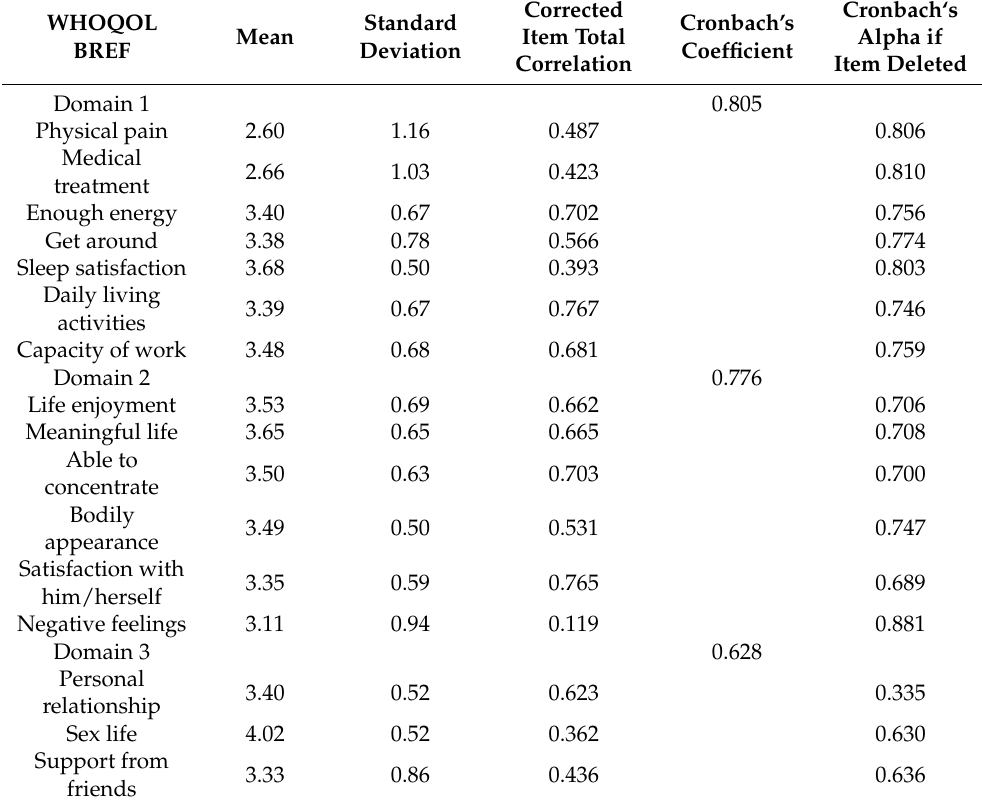
Table 3. Internal consistency of WHOQOL-BREF domains in patients with